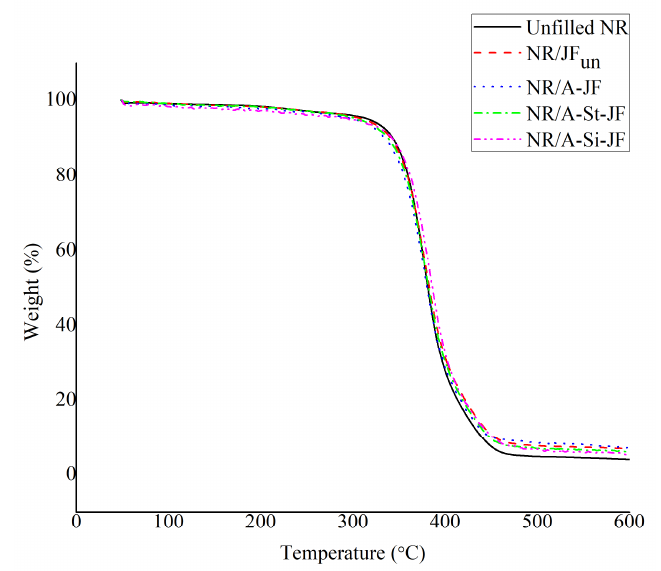
Figure 10. TGA curves of unfilled and JFs filled NR composites. Table 4. Temperatures at different stages of degradation of NR composite.